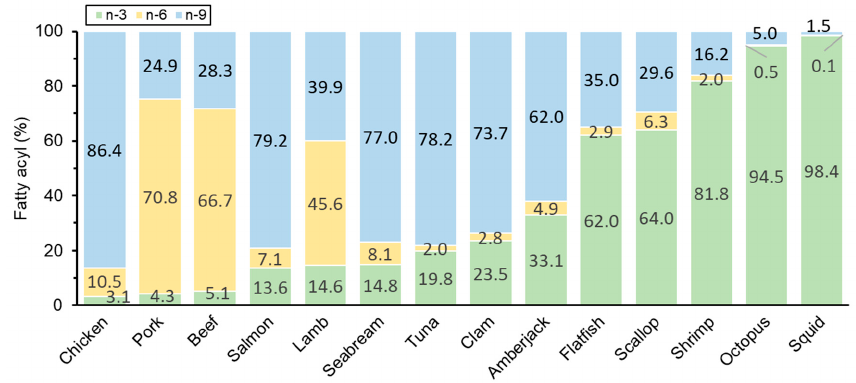
Figure 5. Fatty acyl composition of plasmalogen in foodstuffs. Data were normalized as percentages, and bars of foodstuffs were sorted by the increasing percentage of the n-3 fatty acyl eicosapentaenoyl.